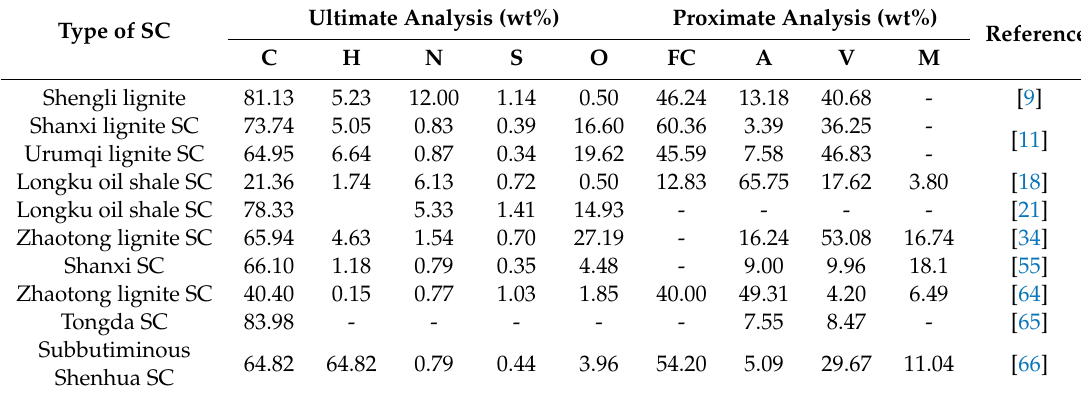
Table 4. Elemental characteristics of some